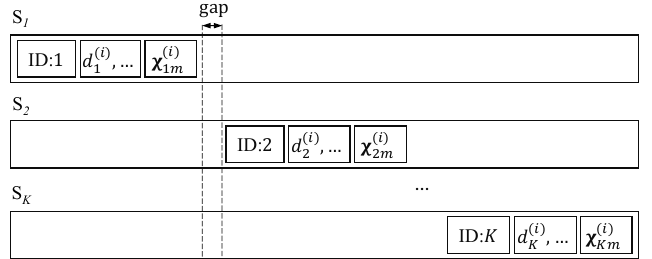
Figure 4. Locations of the attached information in the header of the sending frame of all sources for ( i ) chunk i , where “ d , ...” refers to the information about chunk i for source k such as chunk size d k information about overlapped blocks,